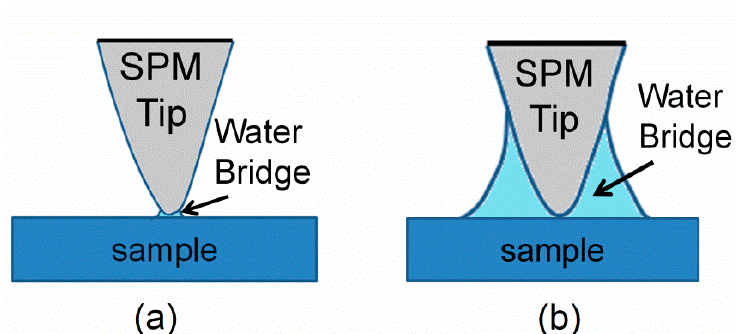
Figure 2. Schematics of the water layer between the tip and the sample surface: ( a ) low relative humidity and ( b ) high relative humidity.